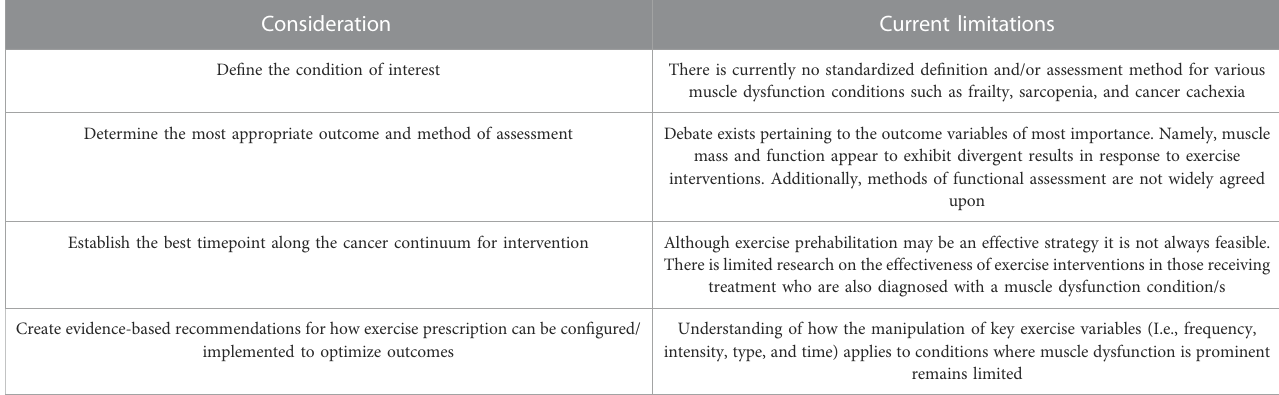
TABLE 2 Overview of suggested considerations for researchers seeking to design studies investigating cancer related muscle